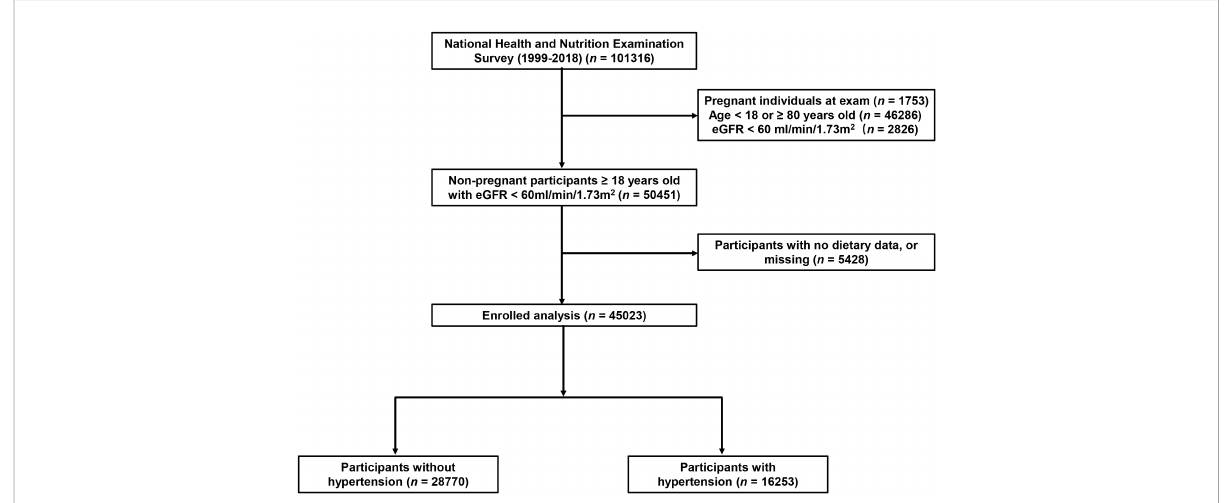
FIGURE 1 Flowchart of the study population. DII, Dietary In fl ammatory Index; eGFR, estimated glomerular fi ltration